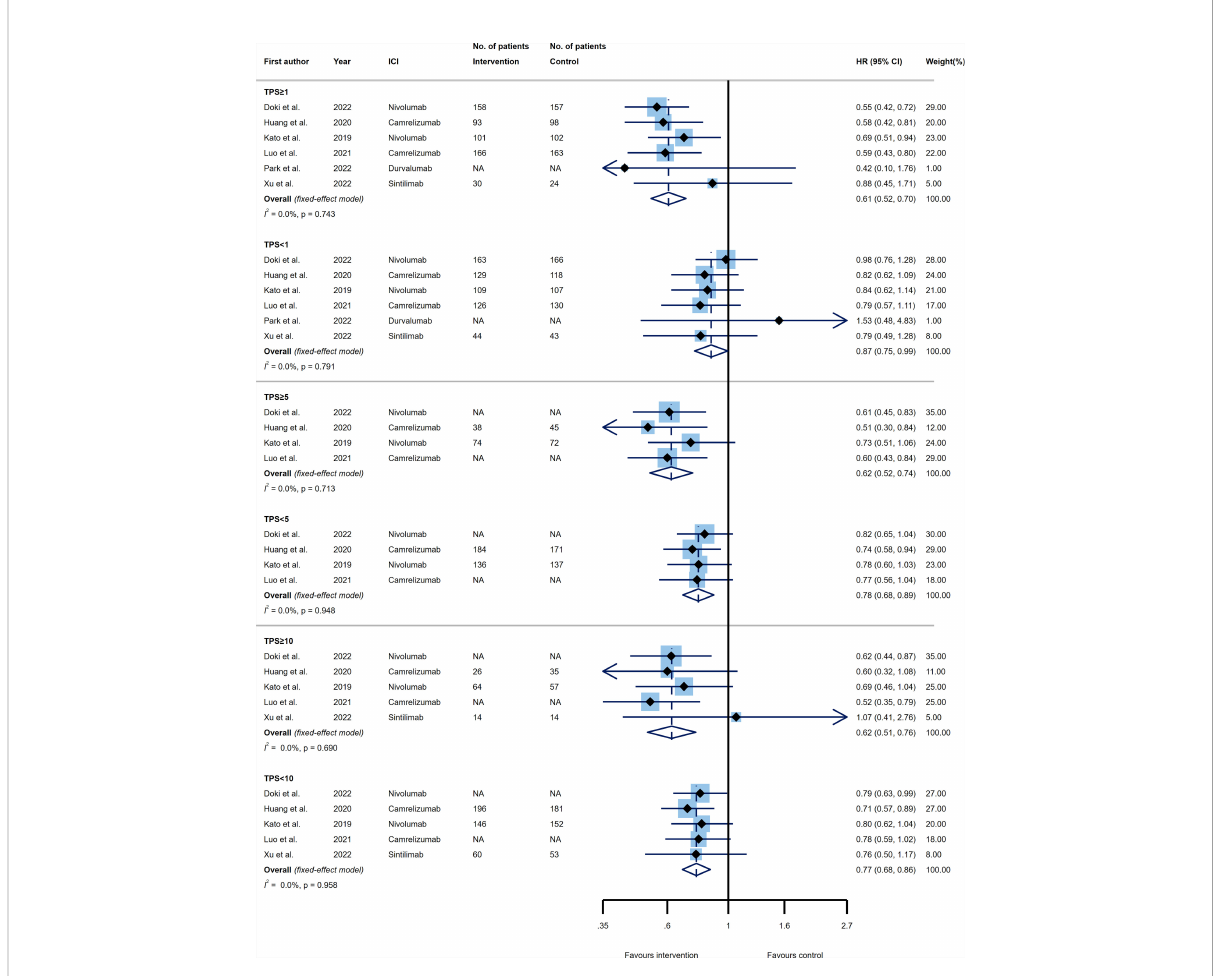
FIGURE 4 Forest plots of overall survival (OS) in PD-L1 high expression group vs . PD-L1 low expression group for the thresholds of tumor proportion score (TPS)=1% (upper panel), TPS=5% (middle panel), and TPS=10% (lower panel). The squares indicate weight of each study based on the fi xed or random ‐ effect model. The vertical dashed line indicates the overall pooled estimate and the diamond the 95% con fi dence interval around that pooled estimate. The forest plot was generated using STATA 17.0 (STATA Corp, LLC,